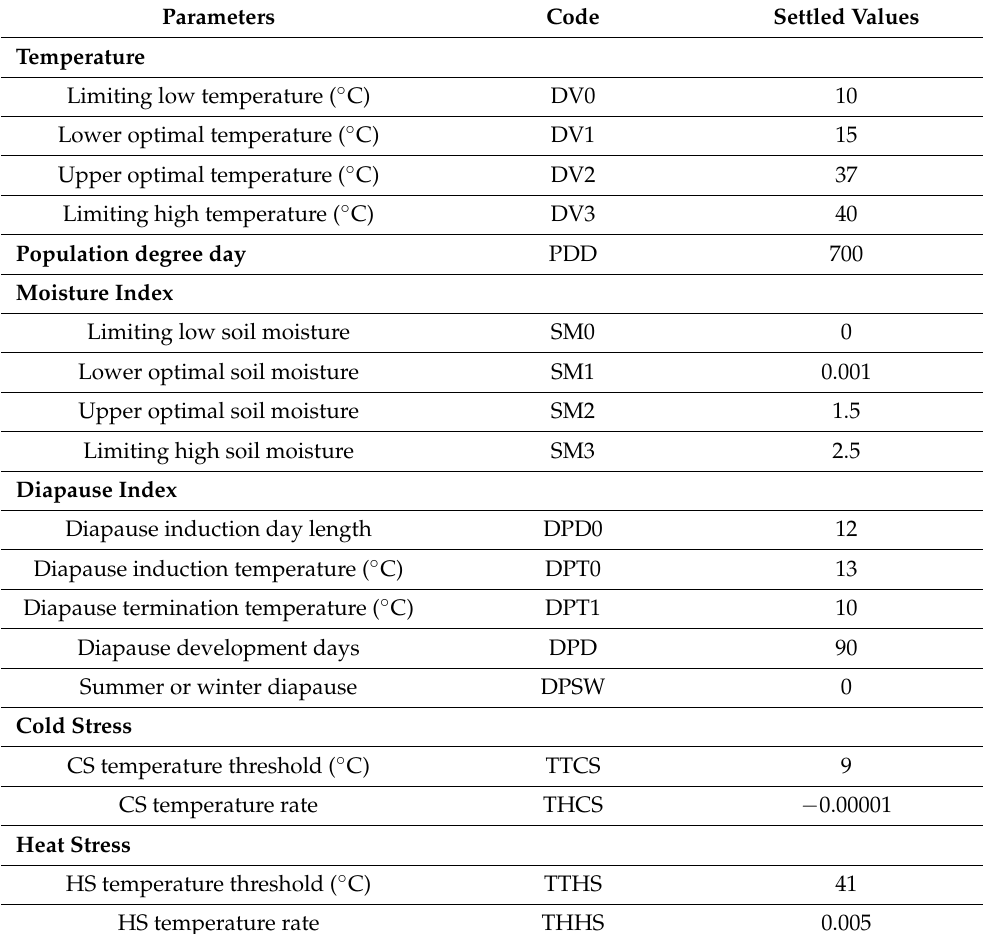
Table 1. Aeolesthes sarta parameter values used in the CLIMEX